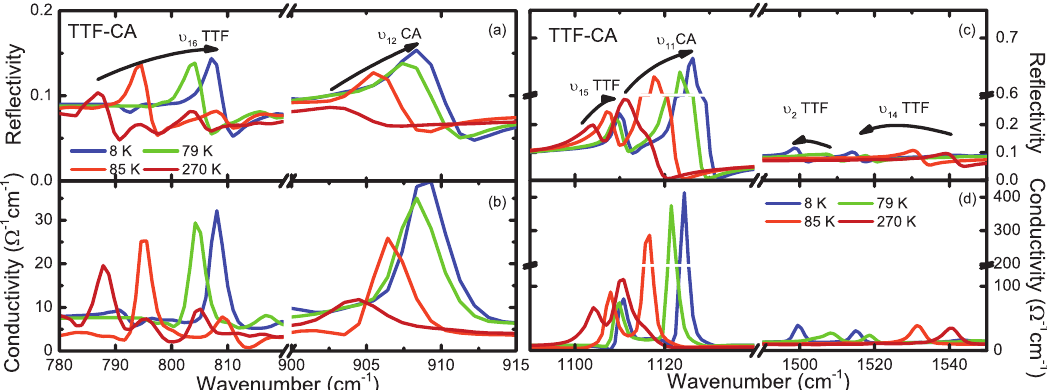
Figure 13. ( a , c ) Reflectivity and ( b , d ) optical conductivity of TTF-CA as a function of temperature in the two different frequency ranges taken at different temperatures as indicated. ( a , b ) The first mode in the region from 780 cm − 1 to 920 cm − 1 can be assigned to the b 1u ν 14 of TTF. The neighboring maximum belongs to the antisymmetric ν 12 -mode of CA, as listed in Table 2; ( c , d ) Between 1000 cm − 1 and 1550 cm − 1 four modes appear whose resonance frequency shifts with decreasing temperature. The ν 11 mode of CA at ν = 1120 cm − 1 has the strongest intensity while the antisymmetric modes of TTF are barely